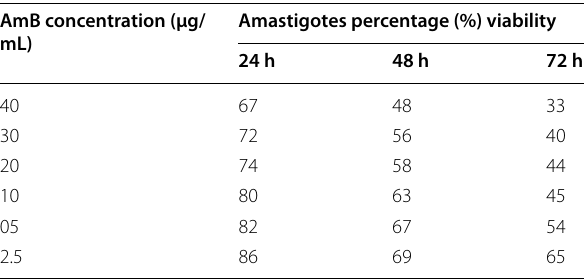
Table 5 Amastigotes viability percentage after treatment